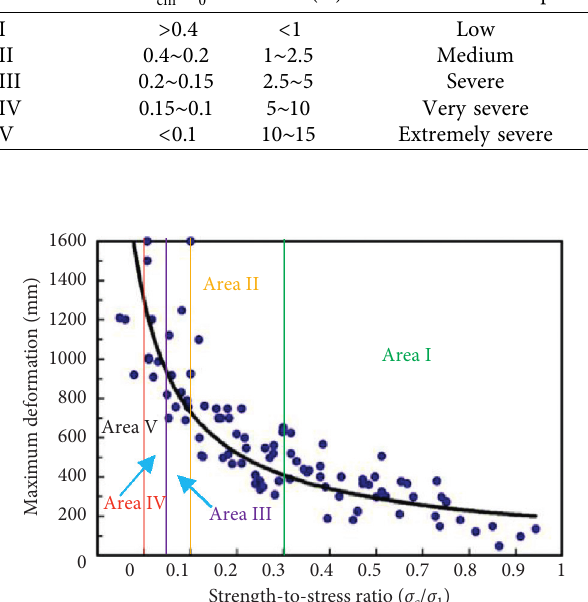
Figure 5: Schematic diagram of the intensity stress ratio classifi- cation of phyllite tunnel in western